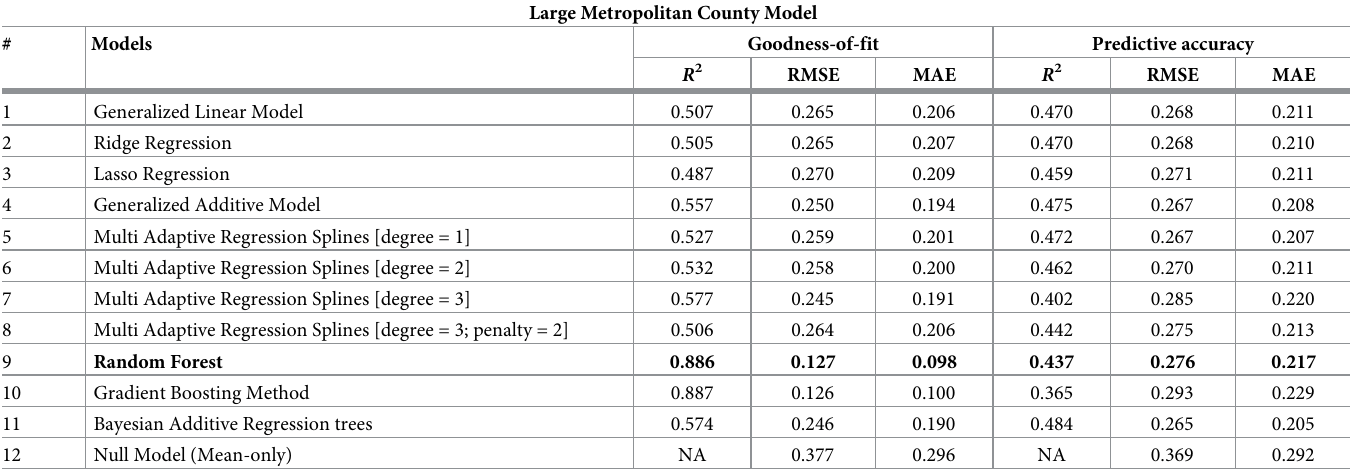
Table 3. Large metropolitan counties: Model performance